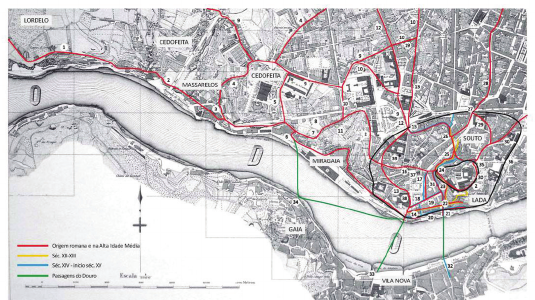
Figure 1 : Porto in the 15th